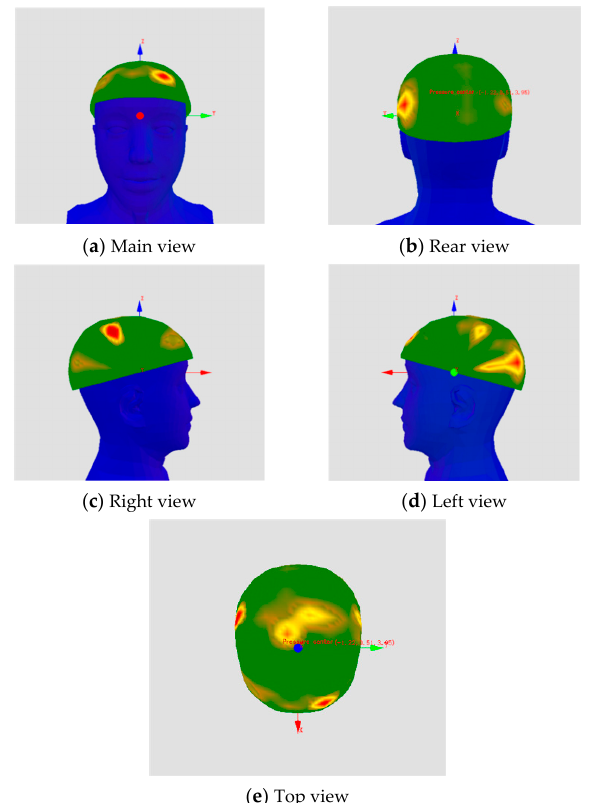
Figure 11. Helmet pressure cloud of one subject.